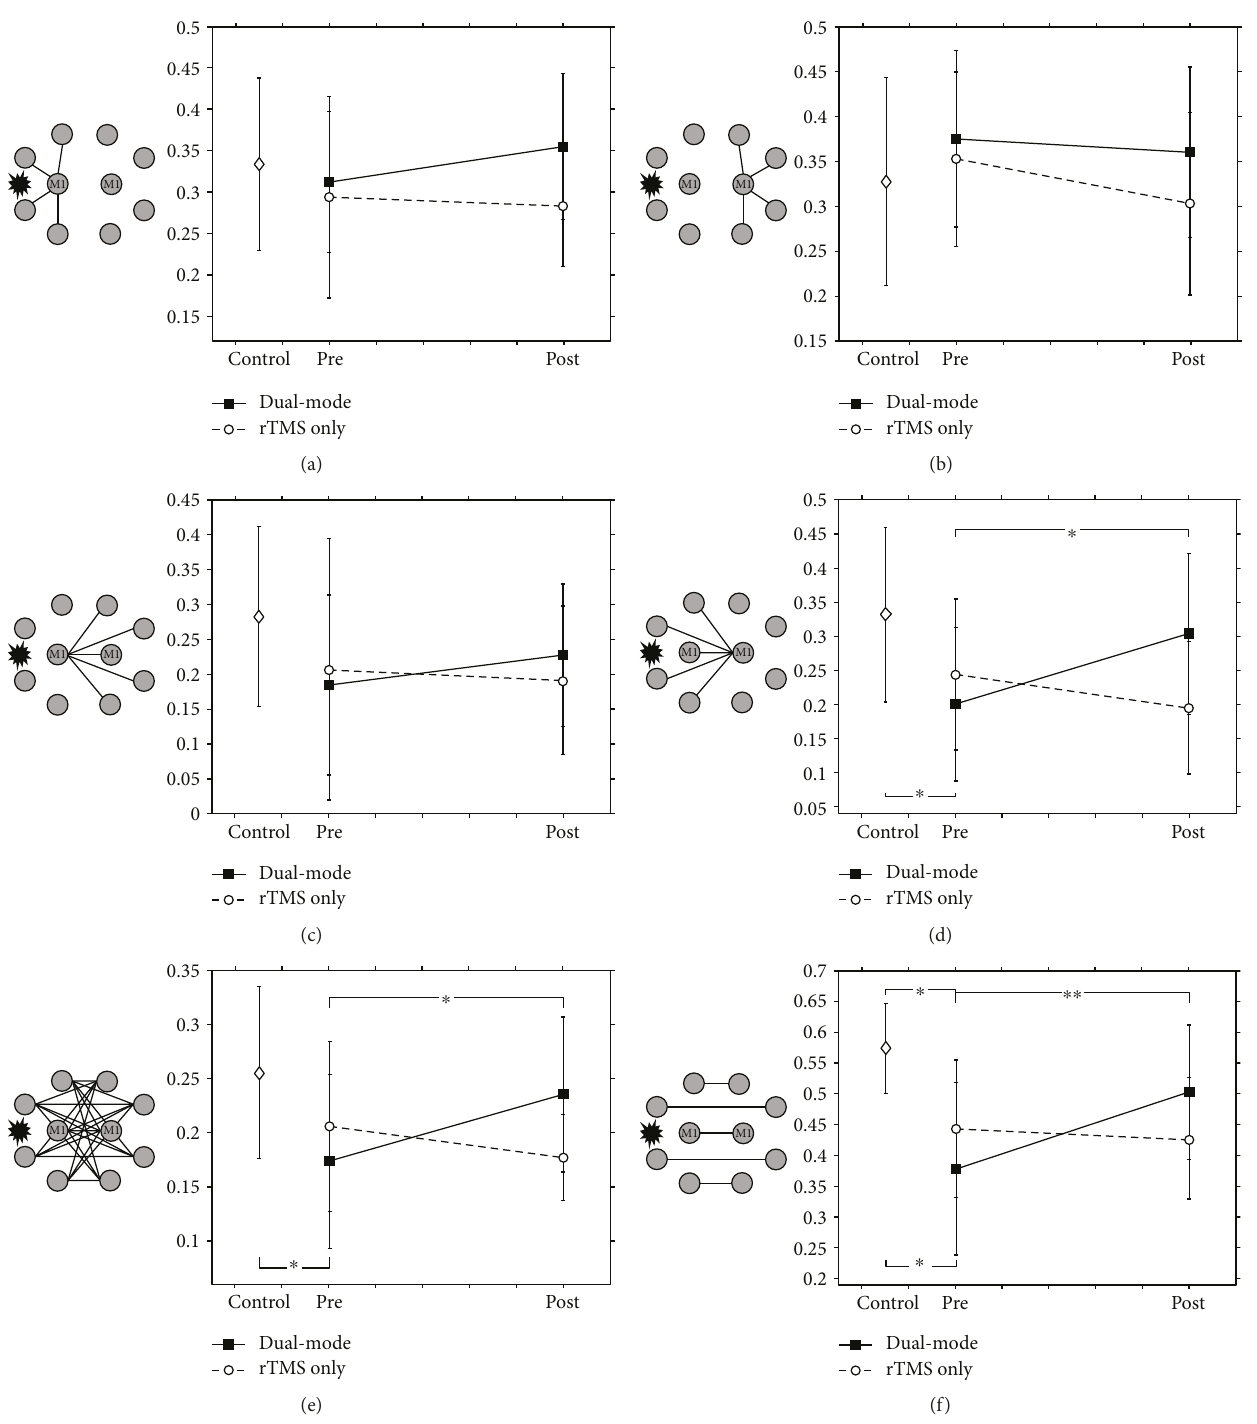
Figure 1: Altered connectivity caused by stimulation. (a) and (b) are the average strength of the intrahemispheric connectivity of bilateral M1. (c) and (d) are the average strength of the interhemispheric connectivity of bilateral M1. (e) and (f) are the average strength of the overall interhemispheric connectivity and interhemispheric connectivity of the homotopic regions. Interhemispheric connectivity of the contralesional M1 and overall interhemispheric connectivity were signi fi cantly increased in the dual-mode stimulation group compared to the rTMS-only group poststimulation ( ∗ p < 0 05 and ∗∗ p < 0 01 ,